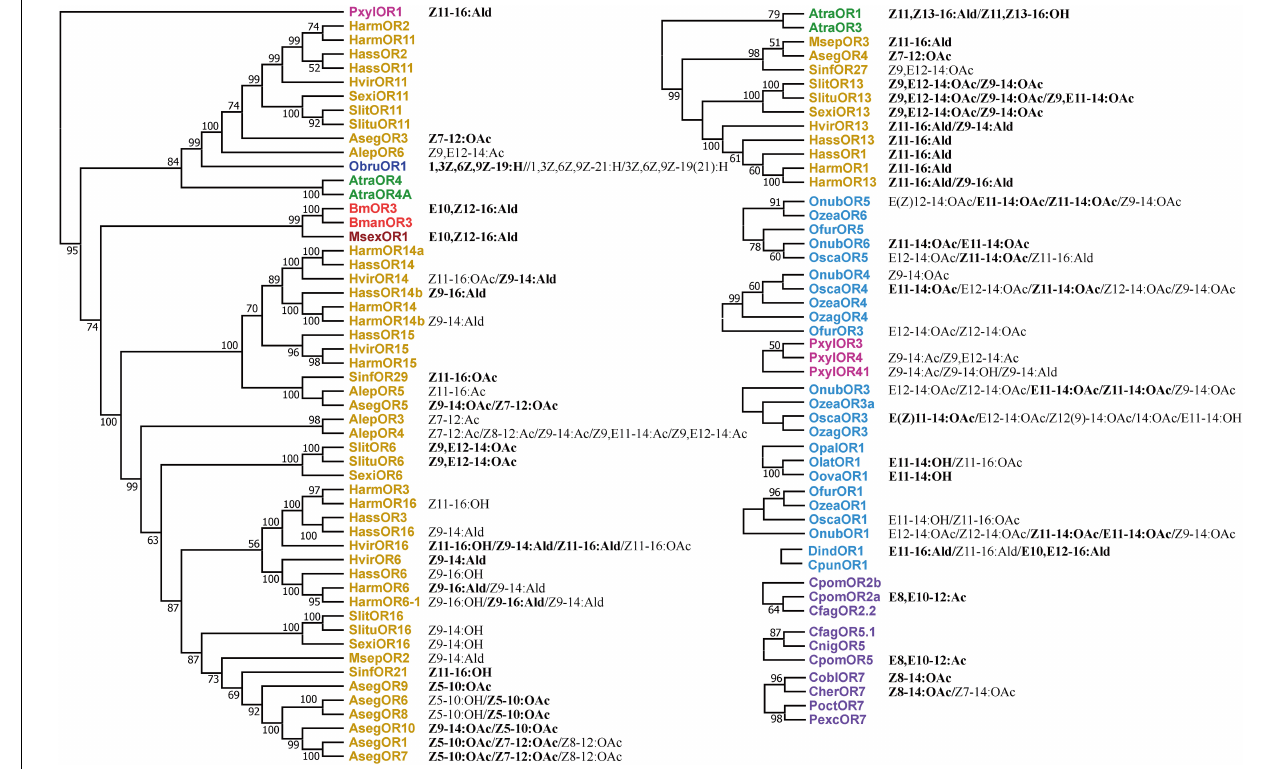
FIGURE 2 | Lepidopteran SPRs and their ligands in the form of phylogenetic branches. Lepidopteran SPR labels and their corresponding family name are in the same color as shown in Figure 1 . The ligands of SPRs are on the right side of each SPR, among which the chemical compound in bold is the sex pheromone molecule (SPM) of the corresponding